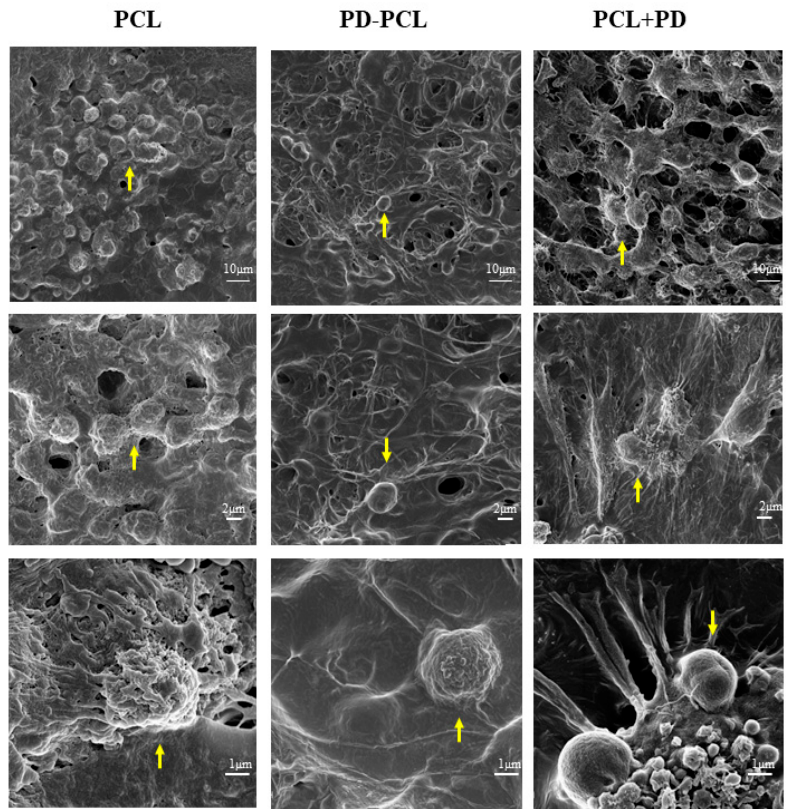
Figure 4. Representative images at different magnifications of Saos-2 cells grown for 14 days on: polycaprolactone scaffold (PCL); PD-coated polycaprolactone (PD-PCL) scaffold; PCL scaffold with 48 µM PD added to the medium (PCL + PD).